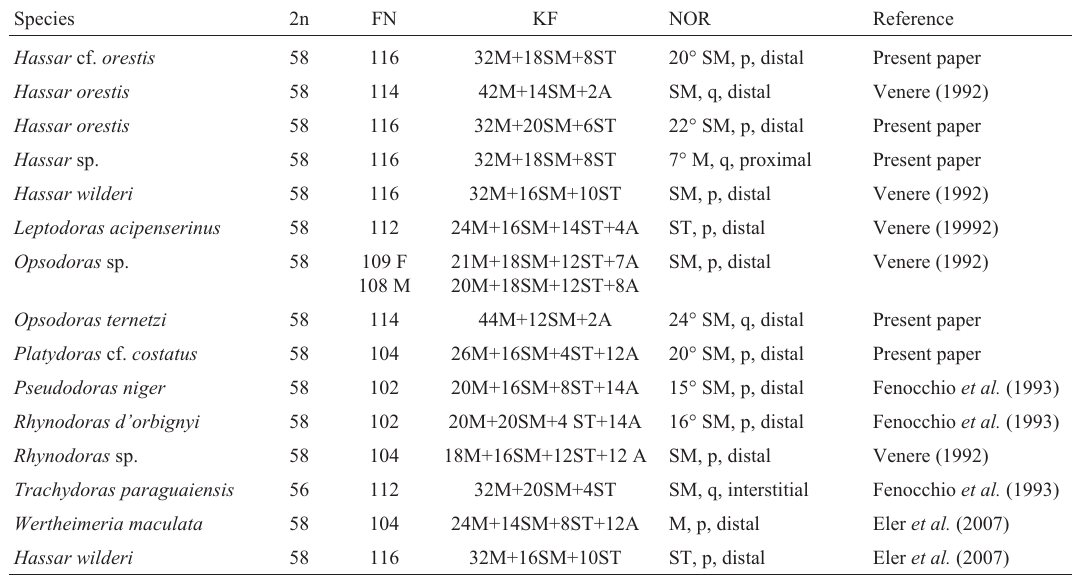
Table 1 - Chromosomal characterization of the family Doradidae. 2n = diploid number; FN = Fundamental Number; KF = Karyotypic formulae; NOR=NucleolarOrganizerRegion;M=metacentric;SM=submetacentric;ST=subtelocentric;A=acrocentric;p=shortarm;q=longarm.M=male; F =